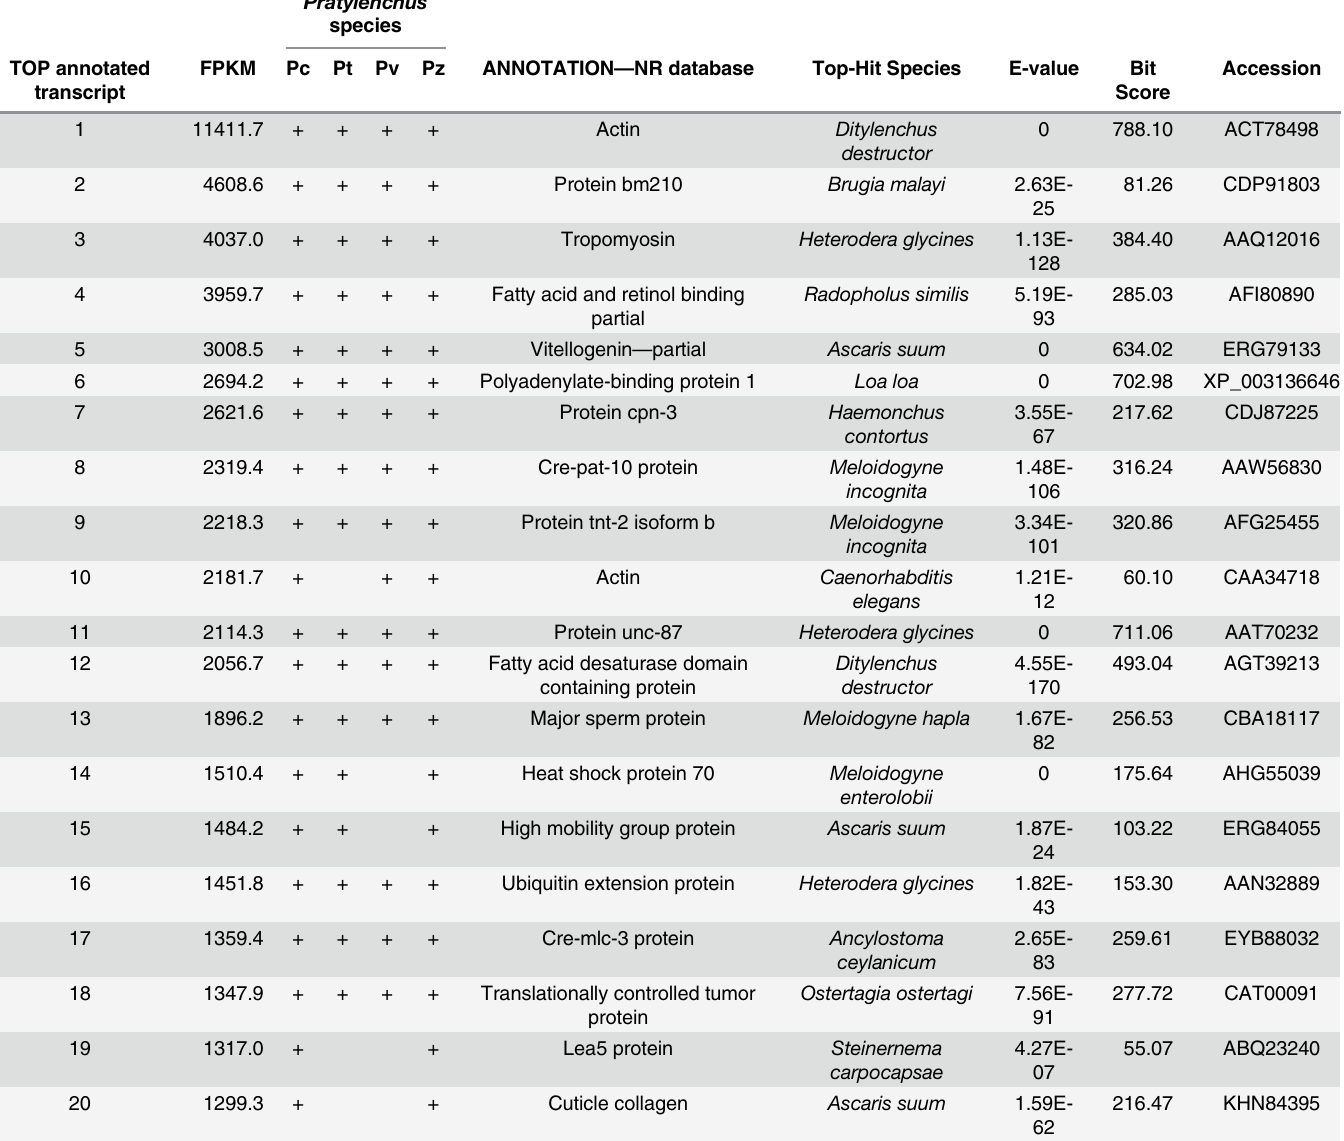
Table 2. List of the top 20 most abundant Pratylenchus penetrans transcripts with annotation to the NR protein